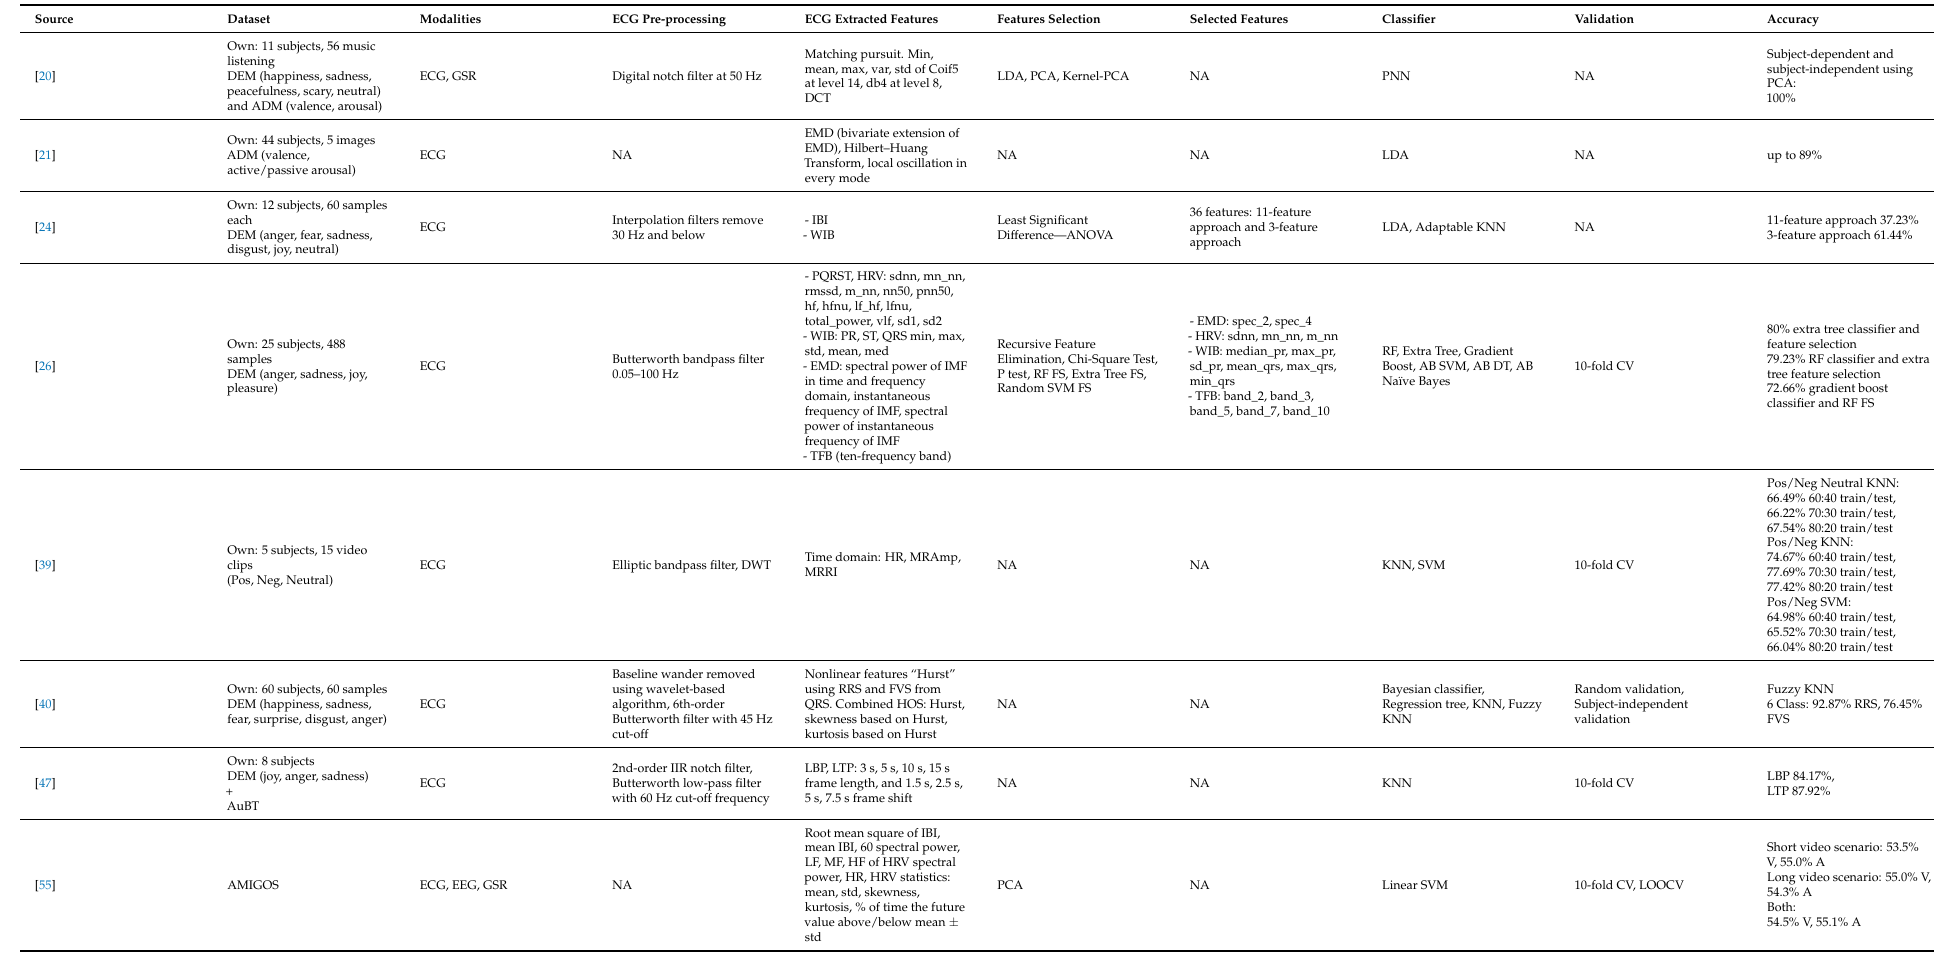
Table 3. Research that only uses ECG as a unimodal approach or a multimodal physiological approach, with ECG standalone accuracy results included.